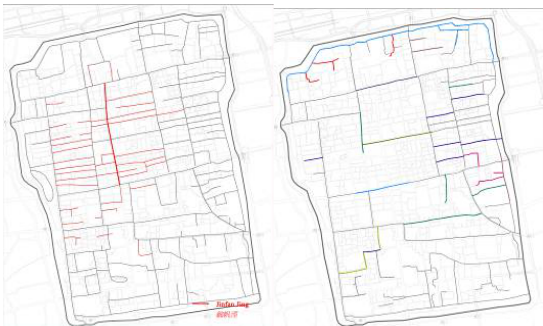
Figure 19. Evolvement of the waterways on spatial distributeon Left: Most dramatic lost waterways during the 16 th -17 th century; Right: Most dramatic lost waterways during the 1950-80’s